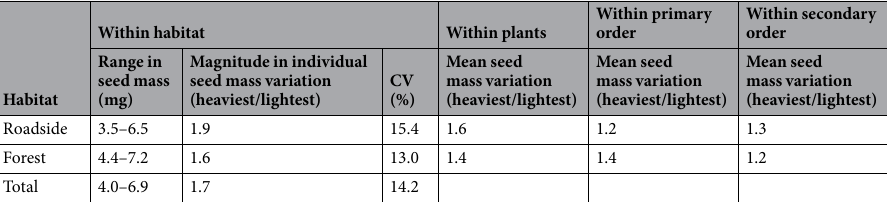
Table 2. Variations in seed mass within sites, individuals, and umbel order. For the determination of average seed mass four replicates of 25 seeds each were